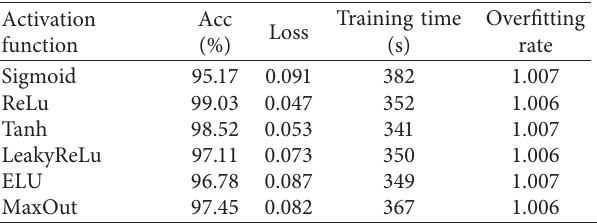
Figure 16: Comparison of behavior training loss of six activation functions. Table 6: Influence of different activation functions on the training effect of deep reconstruction network